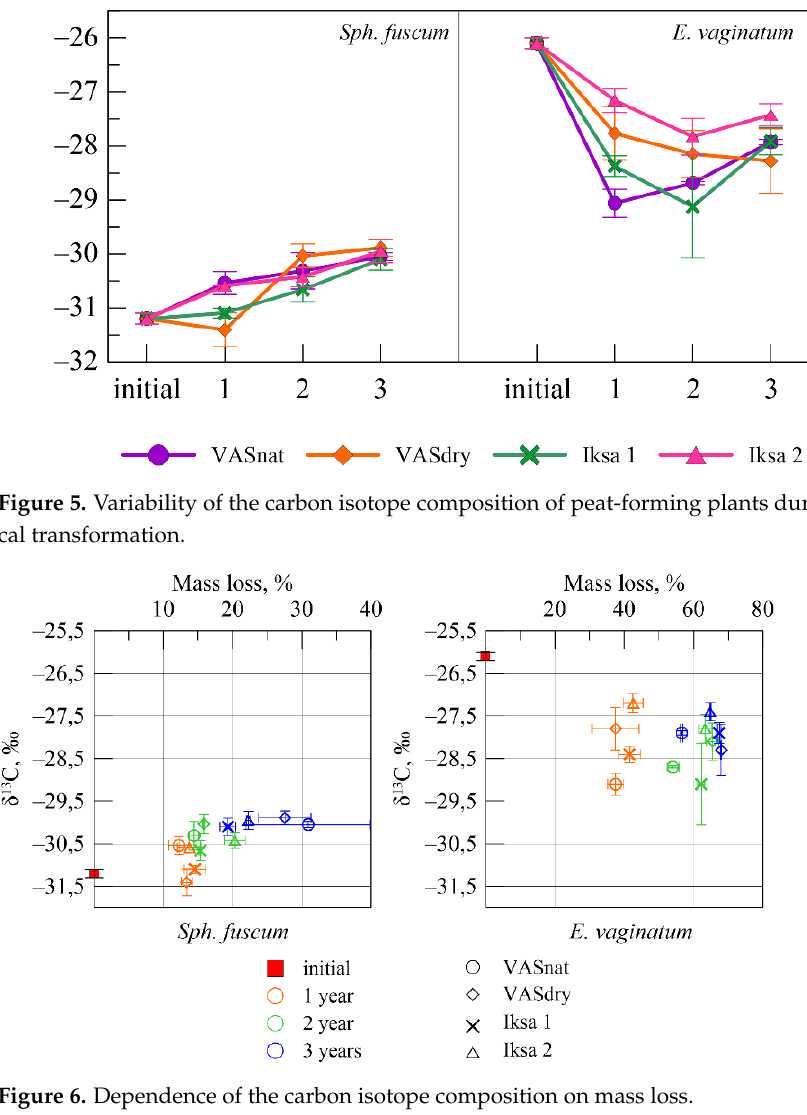
Figure 6. Dependence of the carbon isotope composition on mass loss. Table 2. Summary of the ANOVA for the effect of plant species and location of the samples on value δ 13C in plant